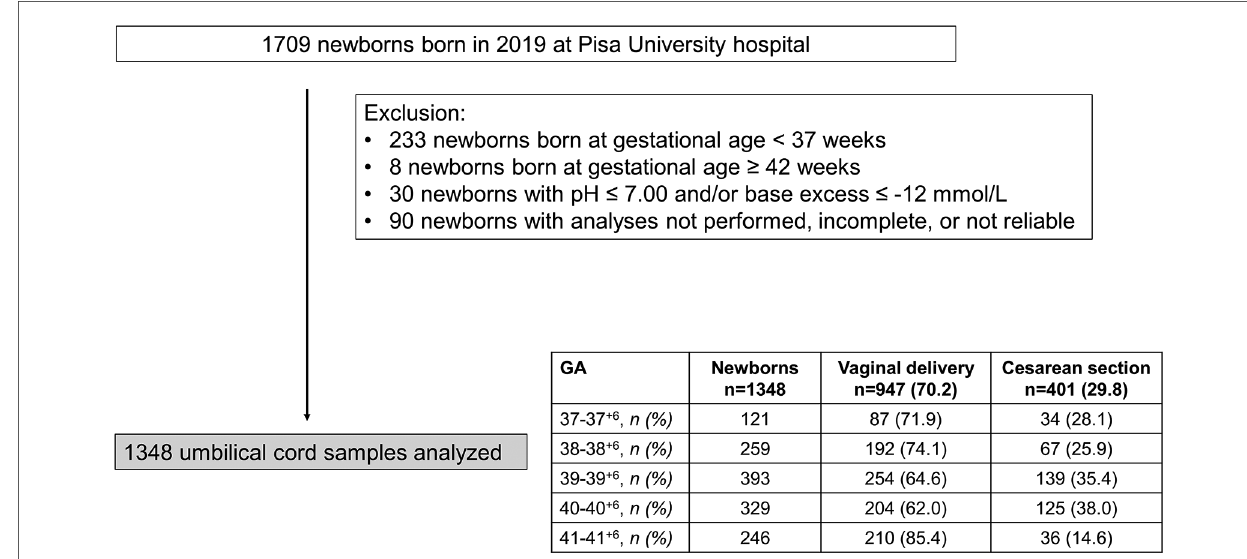
FIGURE 1 Flow chart illustrating patient enrollment of this retrospective observational cohort